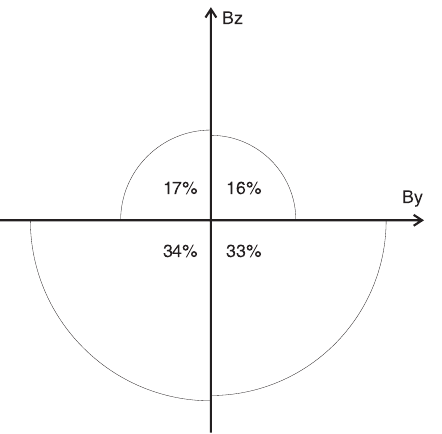
Fig. 7. The IMF Y and Z dependence for all PIF intervals with a clear IMF orientation that were used to deduce the occurrence rate of the transient flow periodicities used to deduce the distribution in Fig. 6. There is a strong dependence on the B component, with 67% z of the intervals occurring during southward IMF conditions. There is no dependence on the B component of y